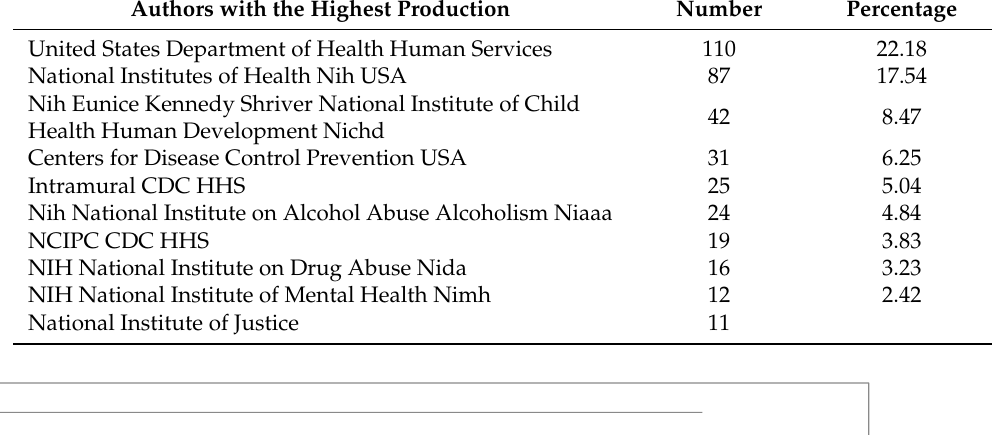
Table 3. Number of documents by affiliation found in the WoS database.